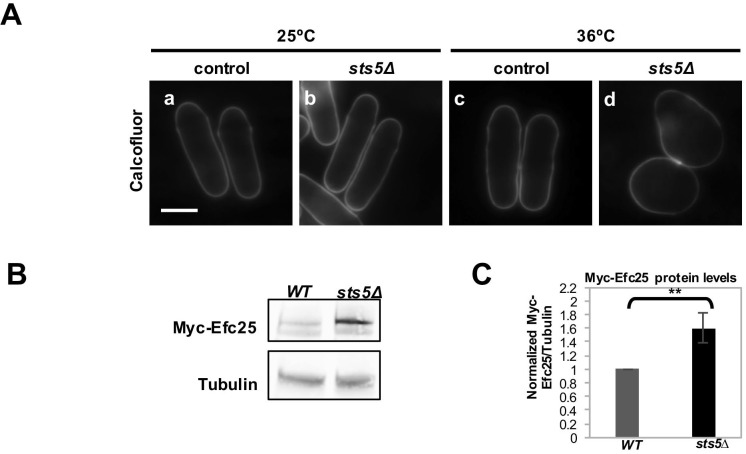
Deletion of sts5 alters cell shape and Myc-Efc25 protein levels.(A) Calcofluor staining of WT (a and c) and sts5∆ (b and d) cultured in YE medium at 25°C and 36°C. Bar = 5 μm. (B) Western blotting against Myc-Efc25 performed as described in Materials and Methods in WT and sts5Δ cells cultured in minimal medium at 25°C. Tubulin levels were determined as a loading control. (C) Quantification of Myc-Efc25/Tubulin ratio normalized to WT levels at 25°C based on 3 independent experiments. Change in Myc-Efc25 level is significantly greater in sts5Δ cells as compared to controls (P = 0.0087, Student’s t-test).